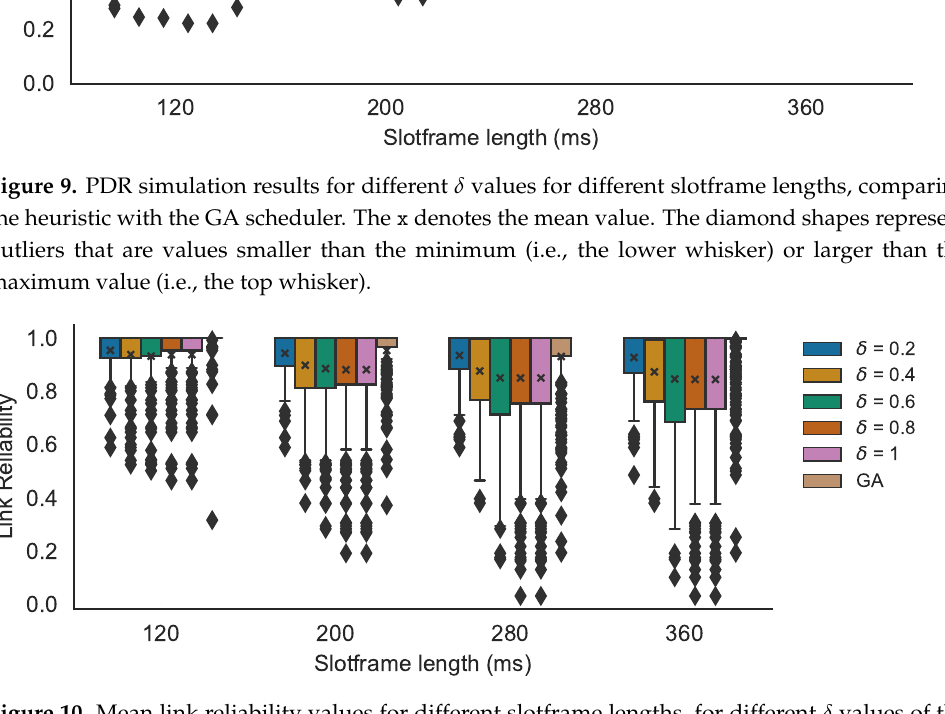
Figure 10. Mean link reliability values for different slotframe lengths, for different δ values of the heuristic. The x denotes the mean value. The diamond shapes represent outliers that are values smaller than the minimum (i.e., the lower whisker) or larger than the maximum value (i.e., the top